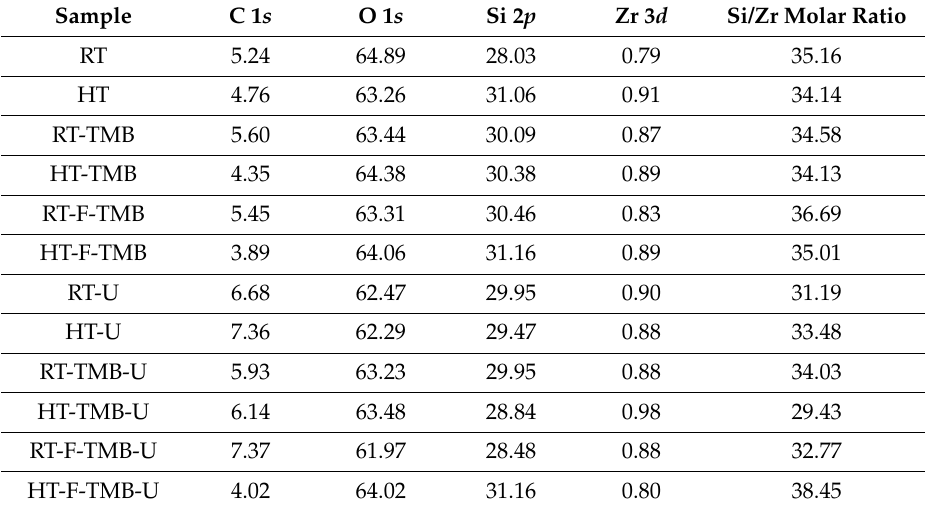
Figure 4. XPS spectra in the C 1 s ( A ), O 1 s ( B ), Si 2 p ( C ), and Zr 3 d ( D ) regions for the RT and HT-TMB, before and after the catalytic tests. Table 2. Atomic concentration deduced by XPS of fresh and spent Zr-dopedsilicas.